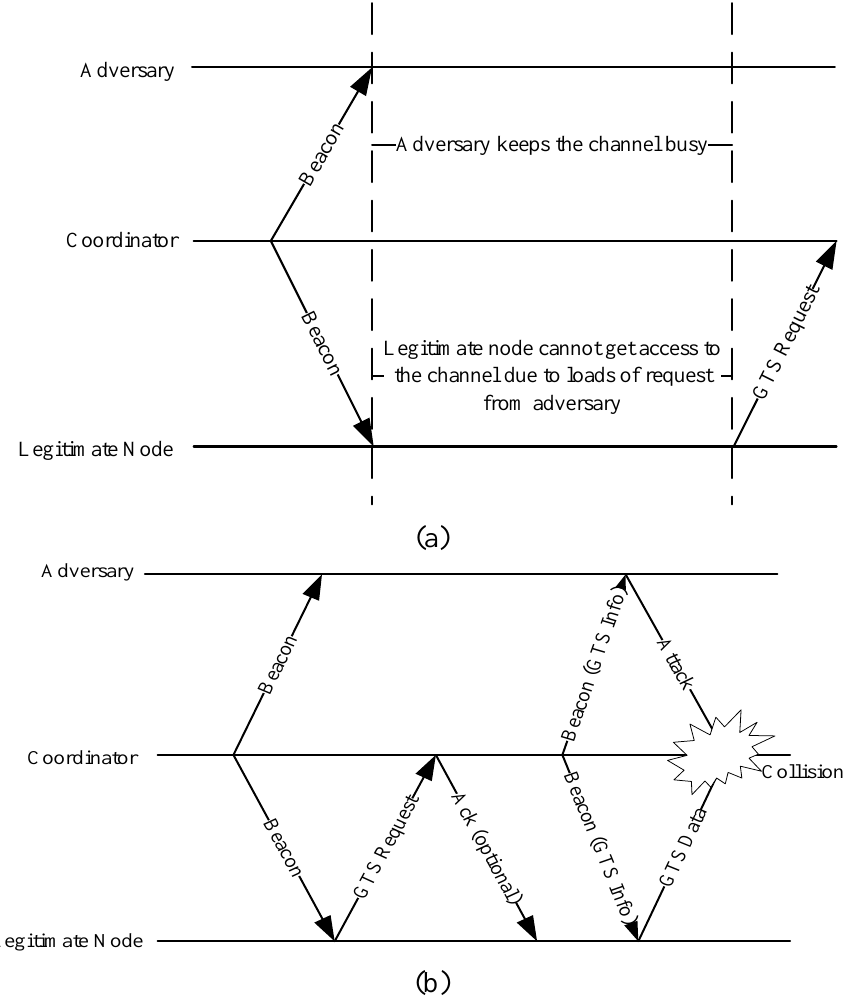
Figure 4. (a) Backoff manipulation attack on the CAP, (b) Attack on CFP